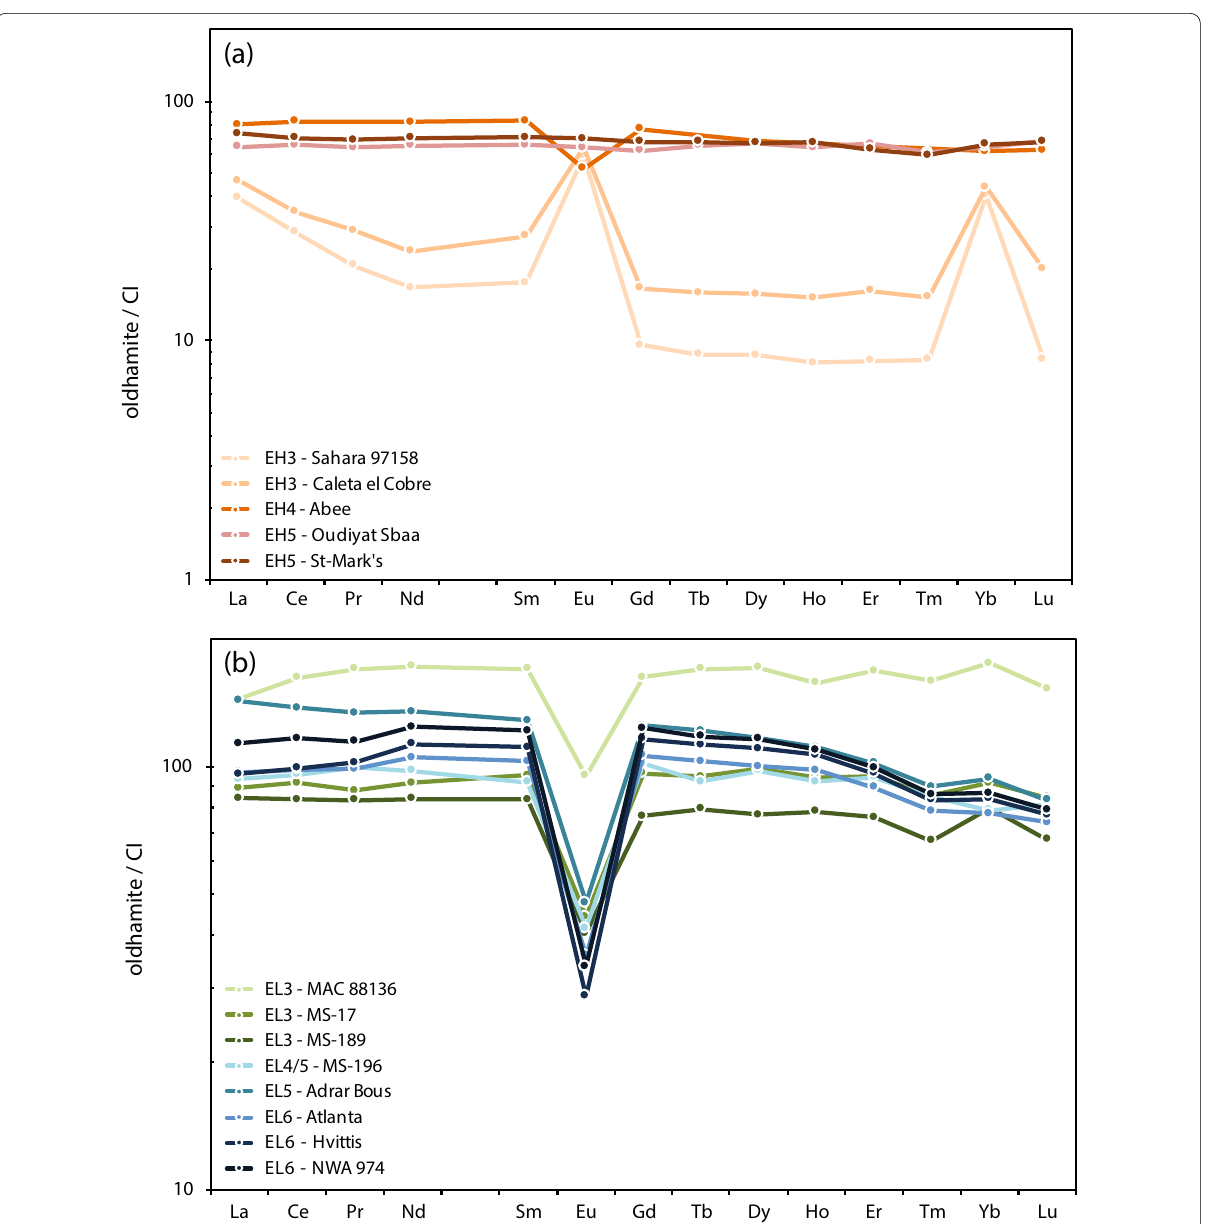
Fig. 4 CI-normalized REE abundances in oldhamites from EH chondrites ( a ) and EL chondrites ( b ). CI values are from Barrat et al.